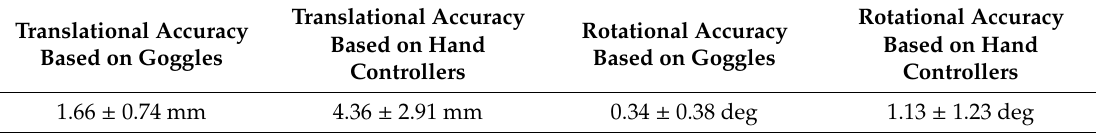
Table 1. Oculus Rift system parameters.